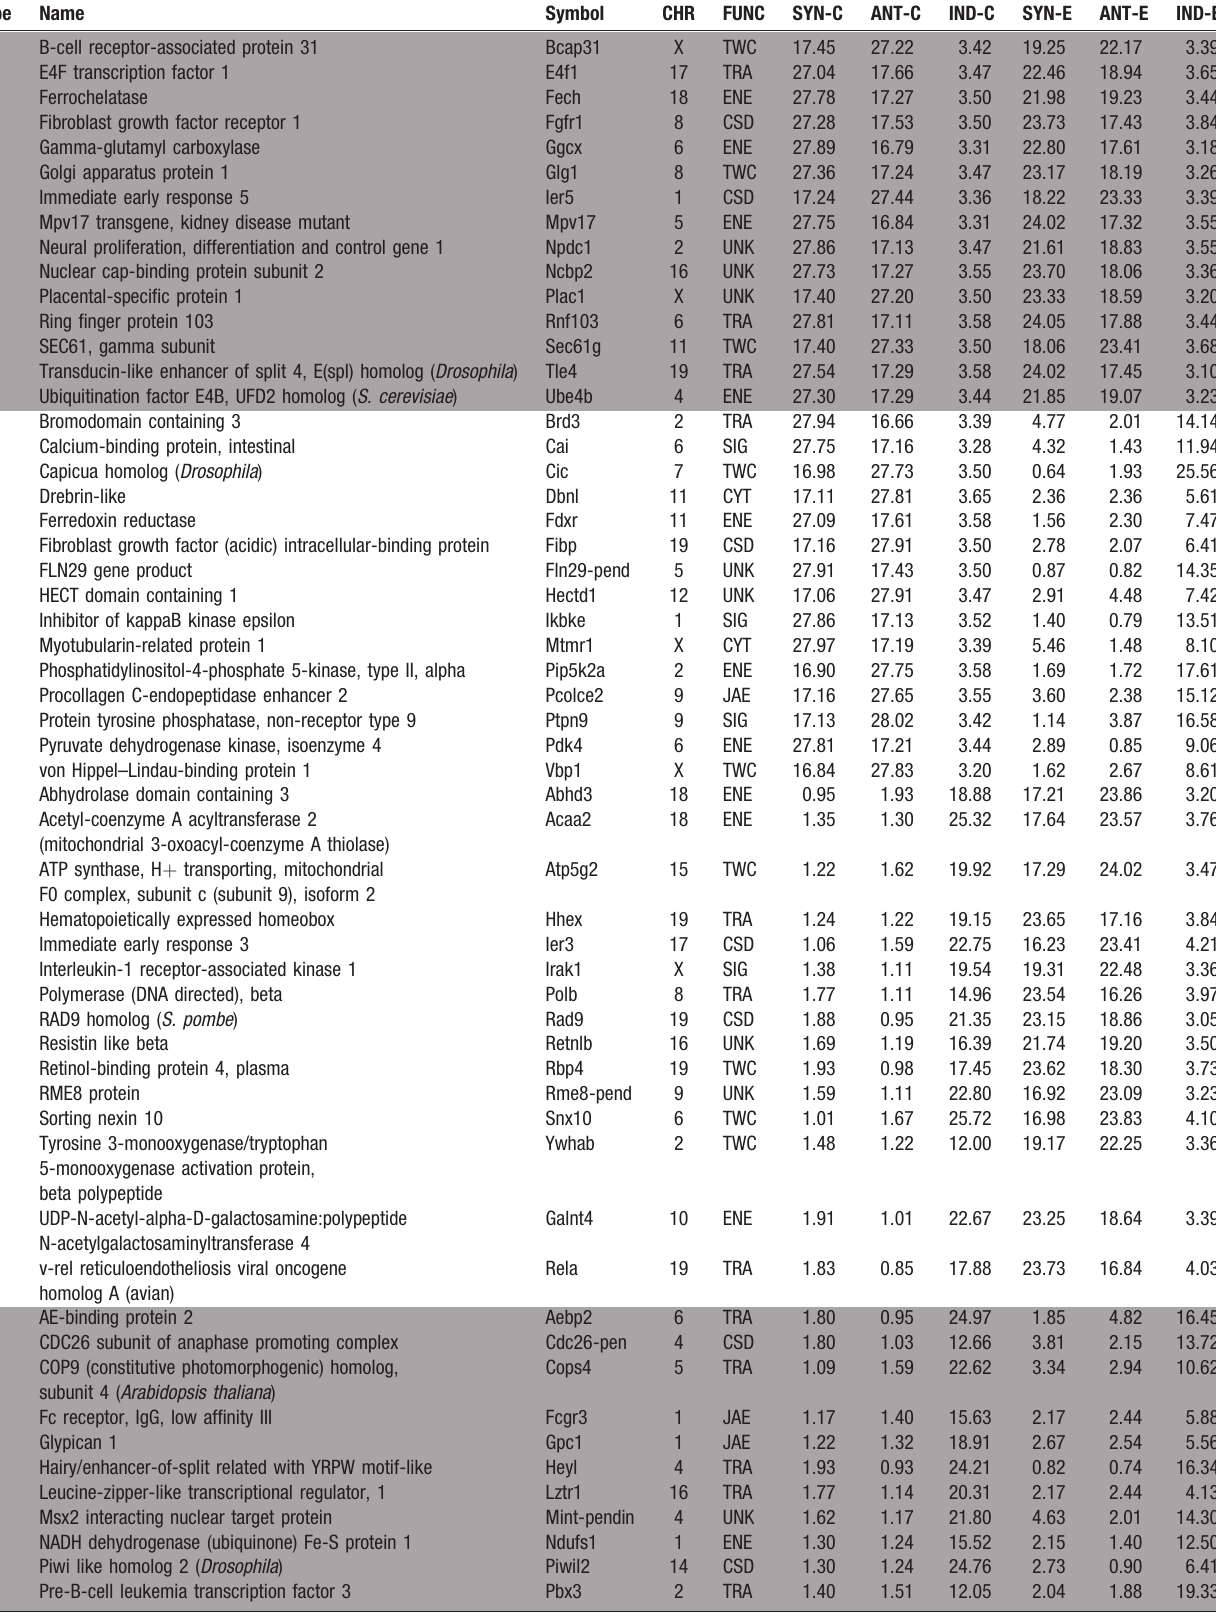
Table 6. Examples of genes that preserved (HH and LL) or significantly changed (HL and LH) the coordination (SYN þ ANT) degree in AT-EAE (E) spinal cord as compared to controls